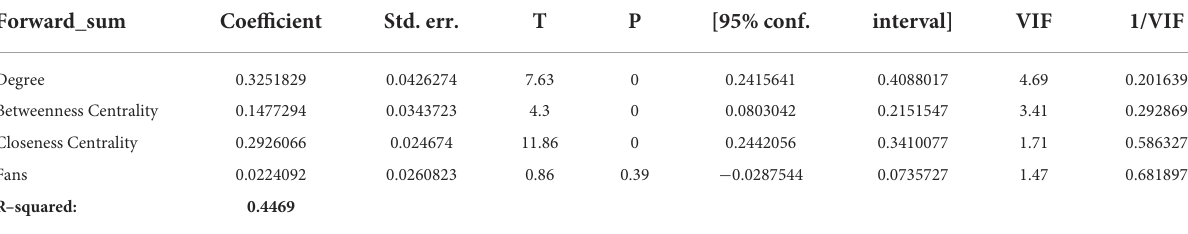
Lower-triangularcellsreportPearson’scorrelationcoefficients,andupper-triangularcellsareSpearman’srankcorrelation.***p < 0.01,**p < 0.05,and*p < 0.1. TABLE 8 Multiple linear regression results of social network